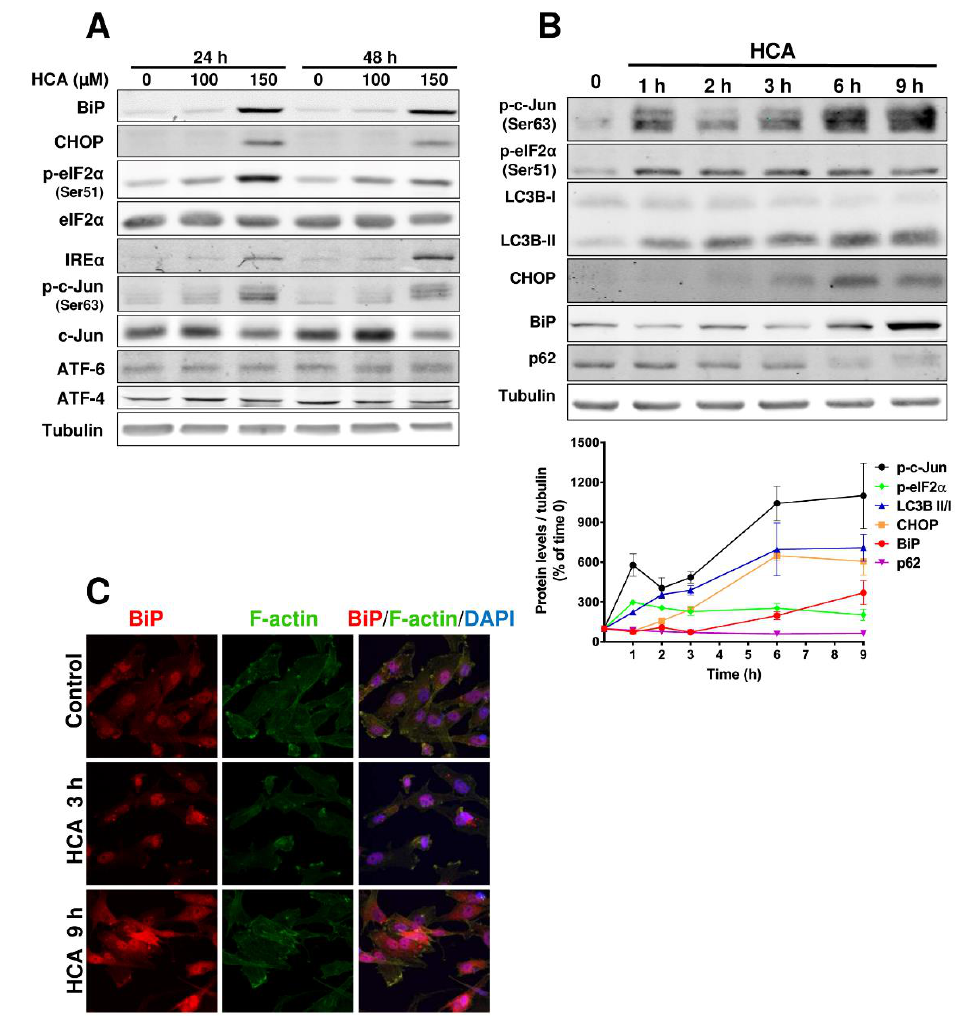
Figure 2. HCA activates ER stress/UPR signaling pathways in U-118 MG GBM cells. ( A ) Representative immunoblots of the effect of HCA (100 or 150 µ M for 24 or 48 h) on eIF2 α and c-Jun phosphorylation, and on the BiP, CHOP, ATF6, ATF4, and IRE α proteins, and the amounts of tubulin in U-118 MG cells as a loading control. ( B ) U-118 MG cells were treated with 200 µ M of HCA for 1, 2, 3, 6, and 9 h, and protein levels or phosphorylation were determined in immunoblots (left) and quantified (mean ± SEM of three independent experiments, right). ( C ) BiP immunofluorescence (red) in U-118 MG cells treated with 150 µ m of HCA for 3 or 9 h. F-actin was labeled with Alexa Fluor 488 phalloidin and the nuclei with DAPI. Representative micrographs (single confocal planes) are shown: scale bar, 5 μm. HCA: 2-hydroxycervonic acid; ATF: Activating Transcription Factor; BiP: